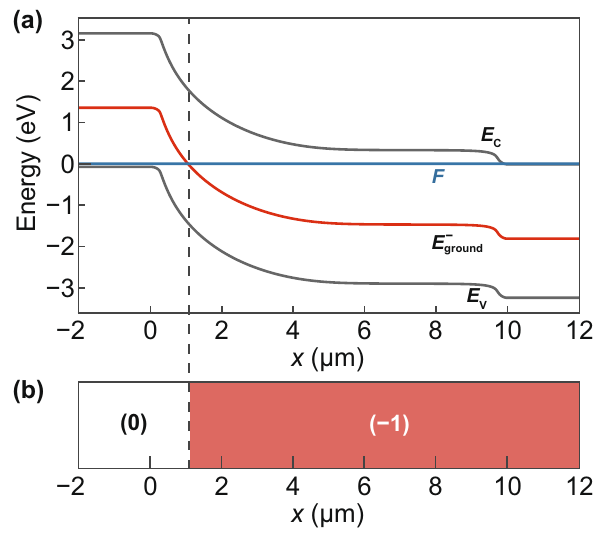
Fig. 6 a Energy-band diagram of the lateral 4H-SiC p + –n − –n + diode shown in Fig. 1 along the line y = 10 nm in equilibrium ( V = 0), F is the Fermi level. The (0|− 1) charge state transition level is illustrated to be 1.9 eV below the conduction band edge of 4H-SiC. b Depend- ence of the charge of the color center on its position in the 4H-SiC p + –n − –n + diode at y = 10 nm for the (0|− 1) charge state transition level shown in panel